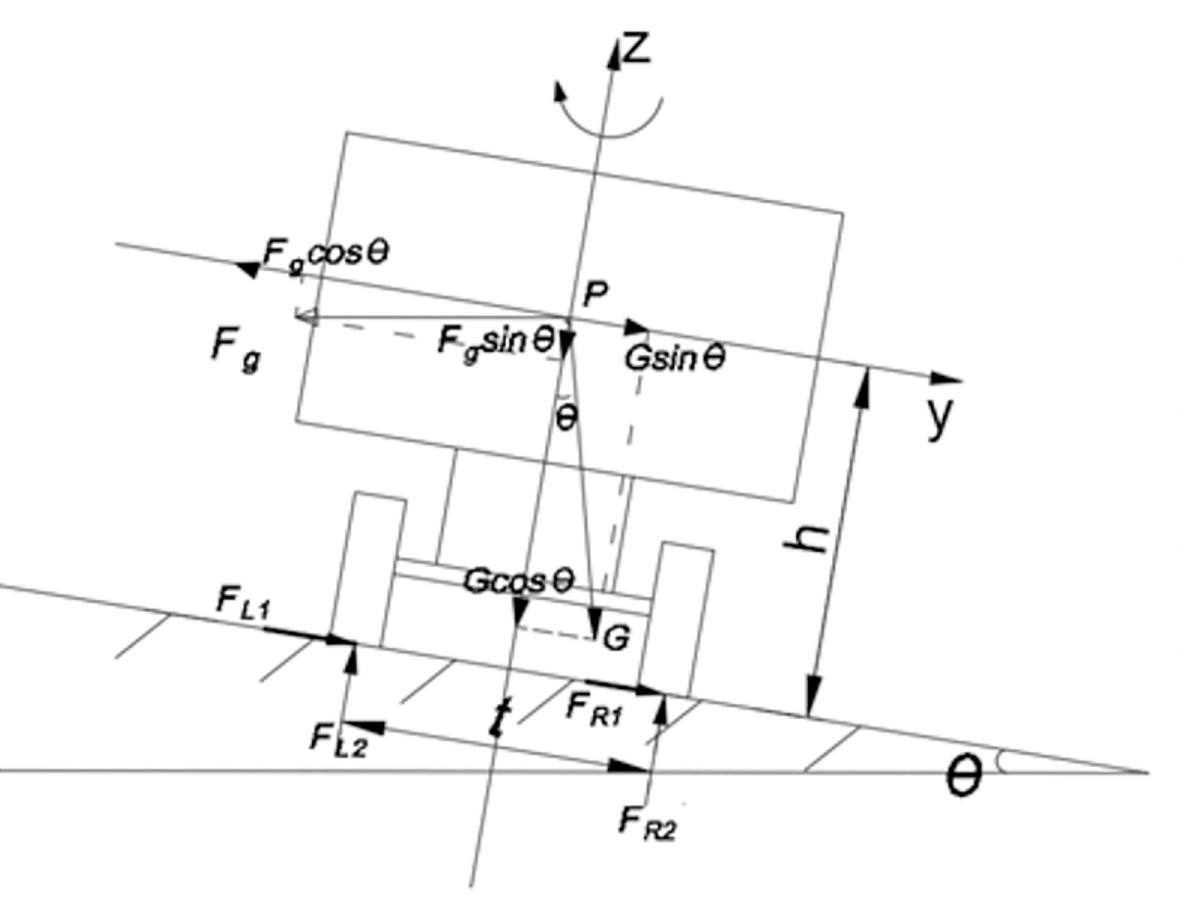
, F were left-hand wheel side forces, N; F L 1 R 1